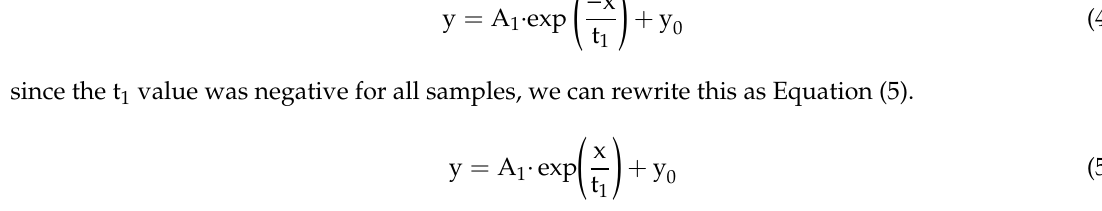
Table 3. Mineral composition of reference sample with cement and fly ash (FA).